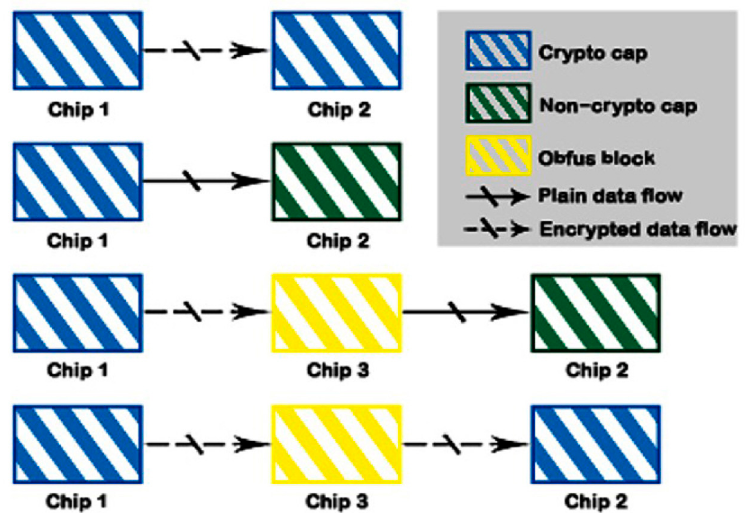
Figure 1. Data encryption and communication between chips [2].